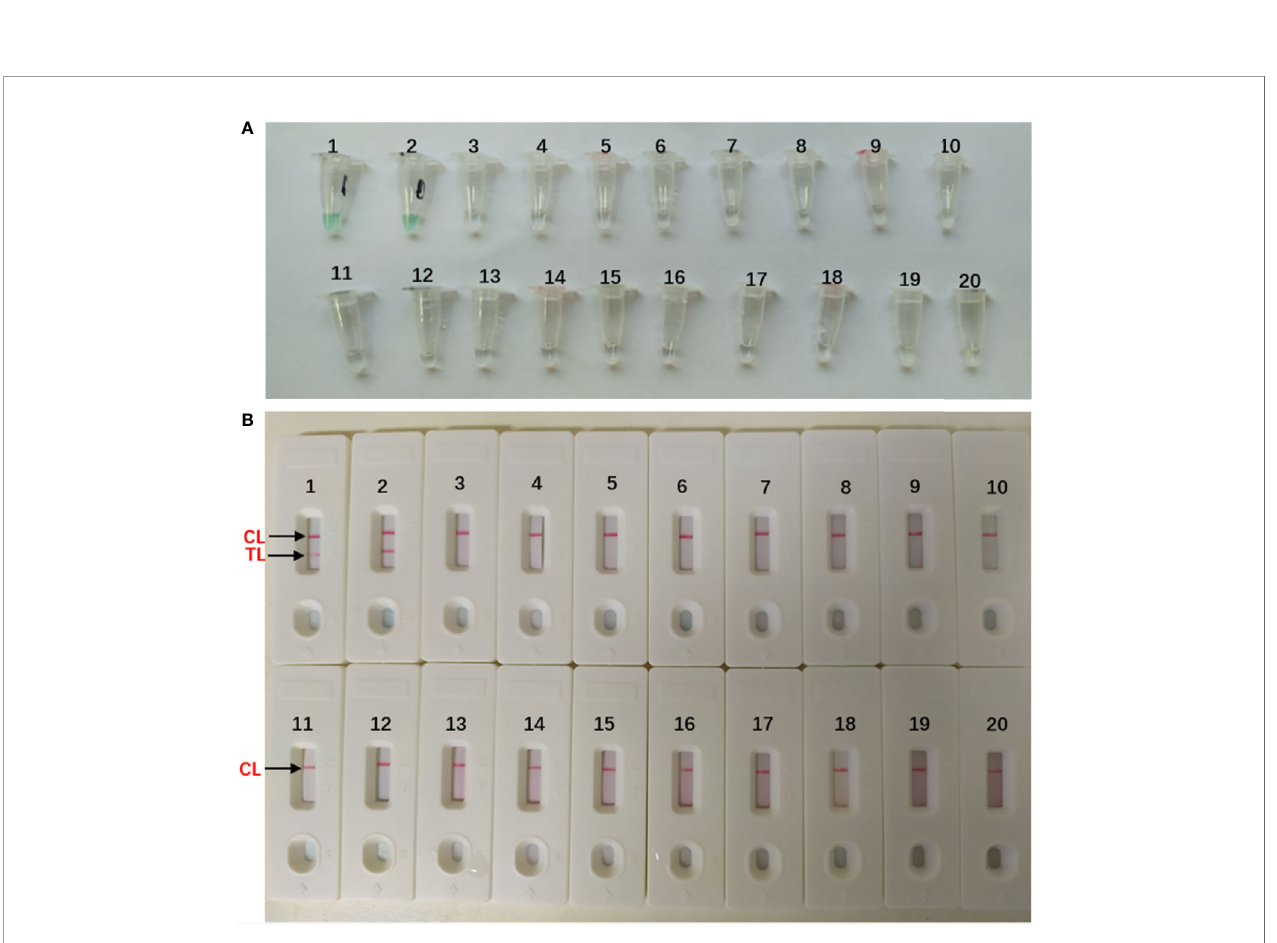
FIGURE 4 | Speci fi city of Aspergillus fumigatus -MCDA-LFB assay (A) Color change of A fumigatus -MCDA tubes; (B) LFB applied for visual detection of A. fumigatus -MCDA products. The MCDA assay were conducted using different genomic DNA templates and these results were analyzed visually. TubeA1, Aspergillus fumigatus (ATCC96918); Tube A2, isolated strains of Aspergillus fumigatus ; Tube A3-18, Cryptococcus neoformans (ATCC13690); Cryptococcus gattii ; Tropical candida ; Candida albic (ATCC10230); Smoothcandida ; Aspergillus niger; Aspergillus fl avus ; Fusarium spp; Pseudomonasaeruginosa ; Acinetobacterbowman ; Penicillium italium ; Dungenterococcus ; Proteus singularis ; S. aureus( ATCC 43300); Streptococcus pharyngitis ; Enterobacter aerogenes . Tube A19-20, blank control (DW). BiosensorB1, Aspergillus fumigatus (ATCC96918); BiosensorB2, isolated strains of Aspergillus fumigatus ; Biosensor B3-18, negative ampli fi cation (The strain is the same as Tube A3-18); BiosensorB19-20, negative control